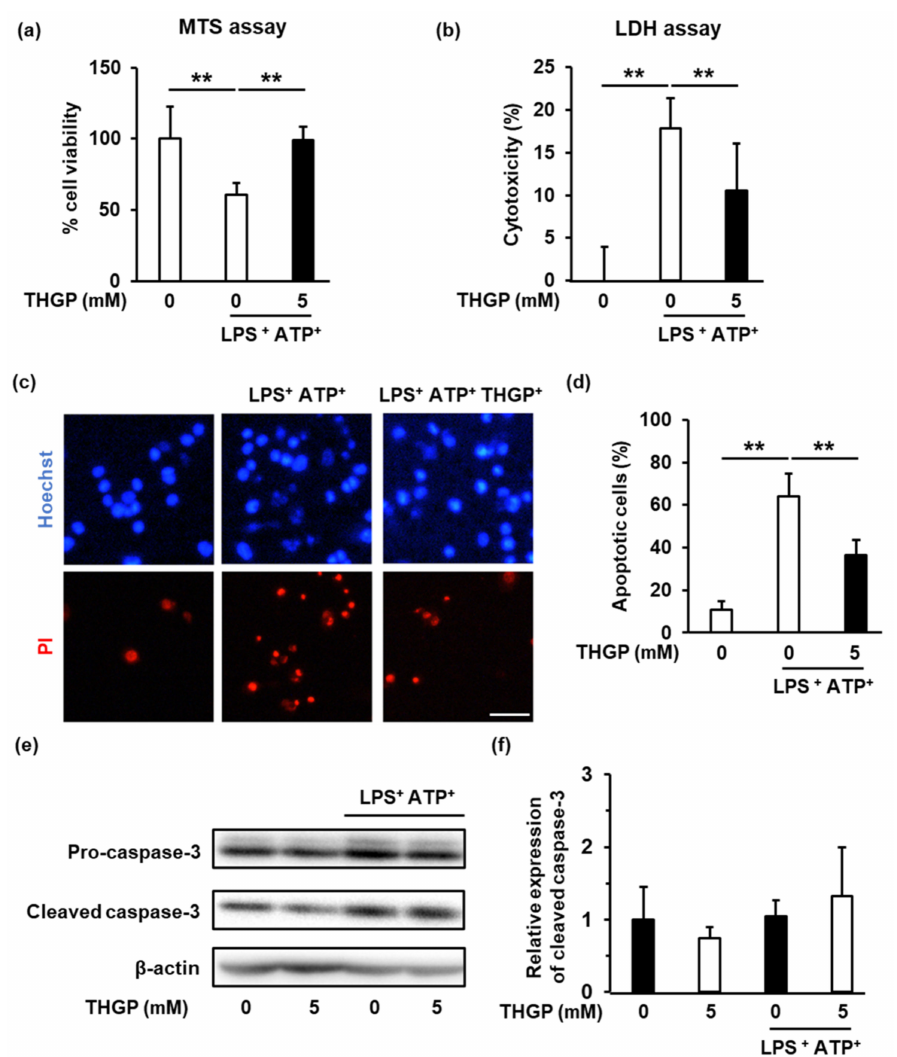
Figure 4. Suppressive effect of THGP on pyroptosis induced by LPS/ATP. ( a ) The viability of THP- 1 cells stimulated with 10 µ g/mL LPS and 1 mM ATP was investigated using the MTS assay. ( b ) Cytotoxicity following LPS/ATP stimulation was investigated using the LDH assay. ( c,d ) The number of dead cells was determined by Hoechst/PI staining. Red and blue cells are dead (PI) and live cells (Hoechst), respectively (Scale bar: 100 µ m). ( e,f ) The expression of caspase-3 was measured by western blotting. β -Actin was used as an internal standard to quantify the expression of each protein. The mean and S.D. are shown. n = 6. ** p <